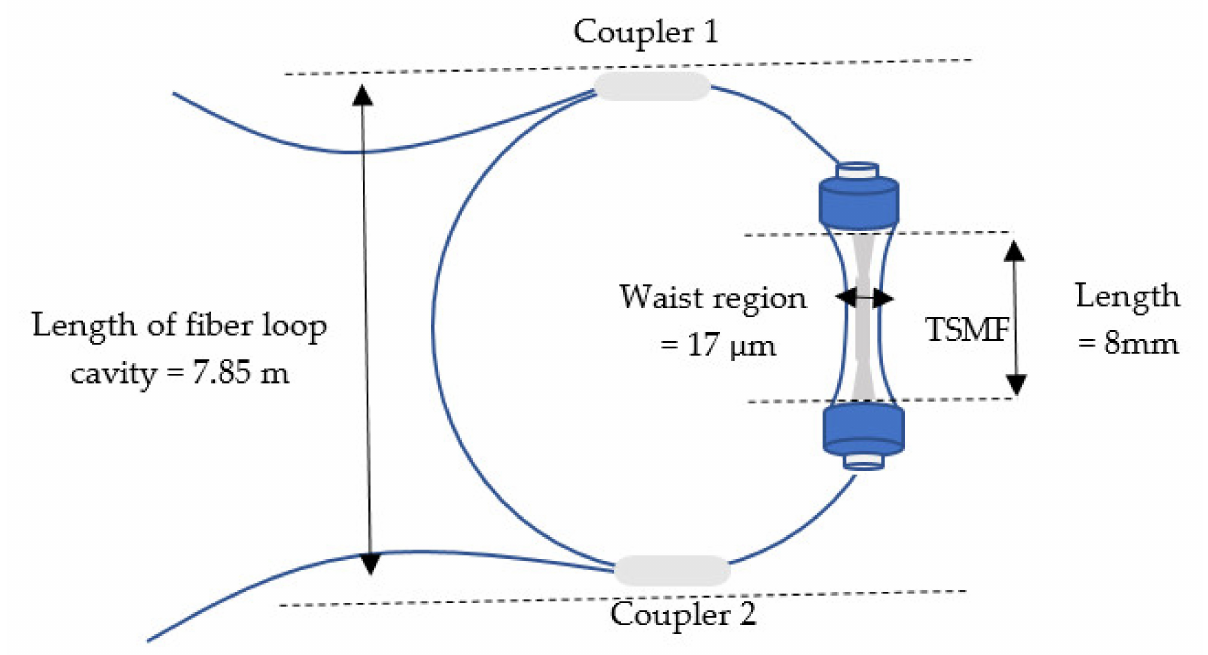
Figure 9. Tapered fiber optic based on fiber loop ring-down (FLRD)